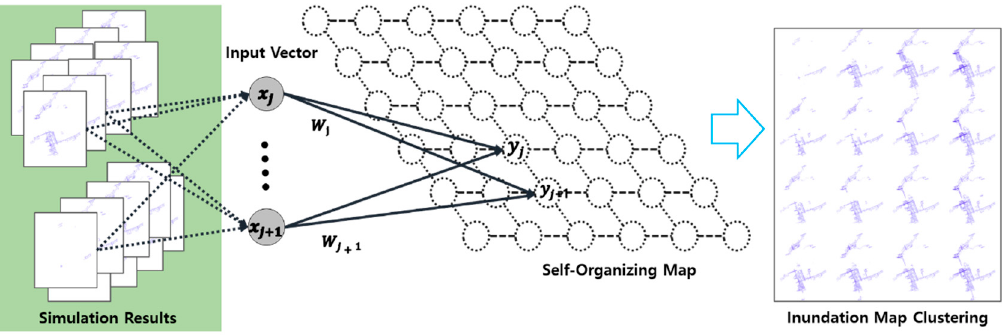
Figure 7. Self-organizing map (SOM) for inundation map clustering (4 × 4). Table 3. Maximum flood area of SOM input data inundation map.